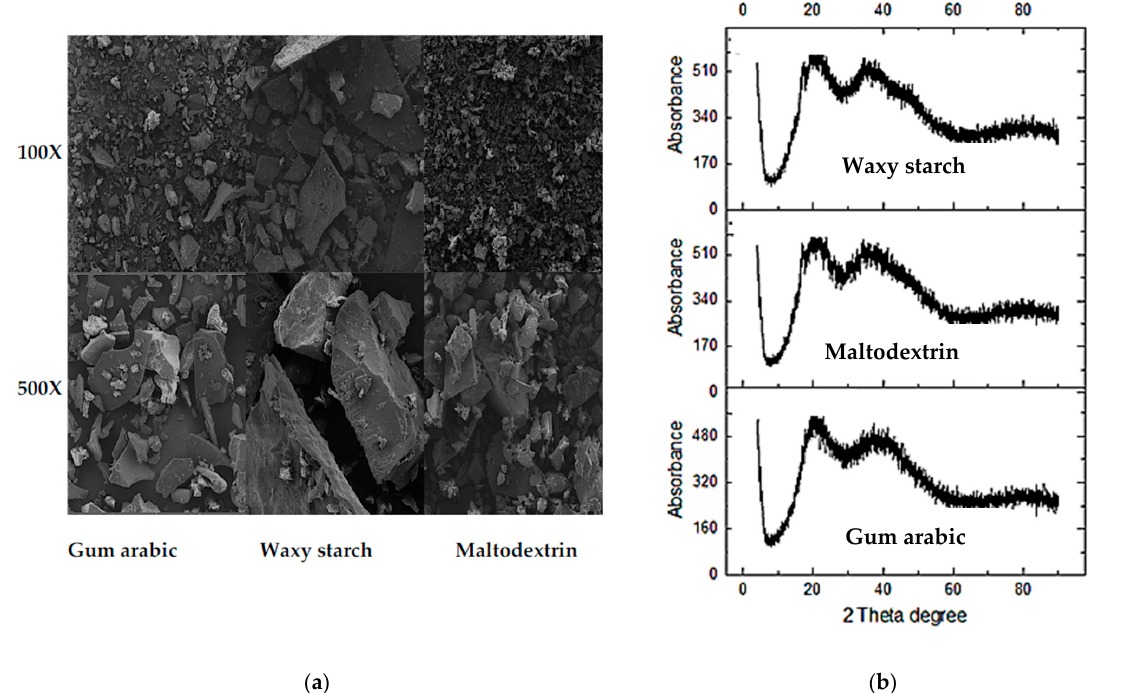
Figure 3. ( a ) Scanning electron microscopy micrographs, and ( b ) X-ray diffraction analysis of freeze- dried passion fruit peel powders developed using different carriers.